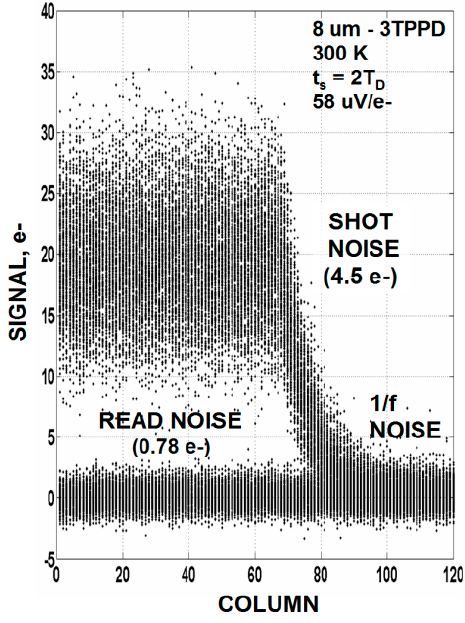
Figure 6. Raw video response for a sub carrier noise 3T PPD pixel in response to a light source that slowly turns off. Read noise for this pixel is 0.78 e − rms.